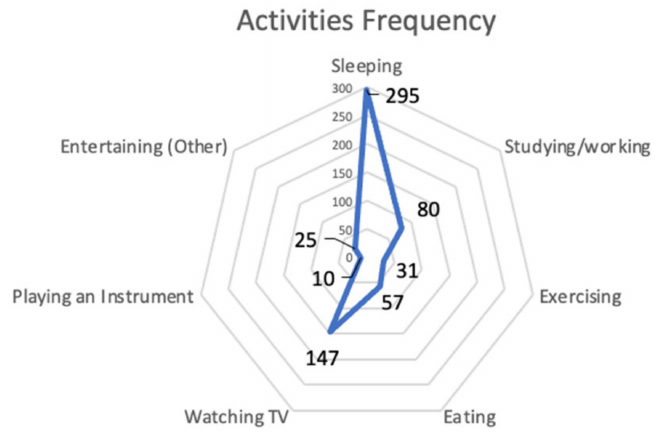
Figure 2. Representation of the activity frequencies in the sleep